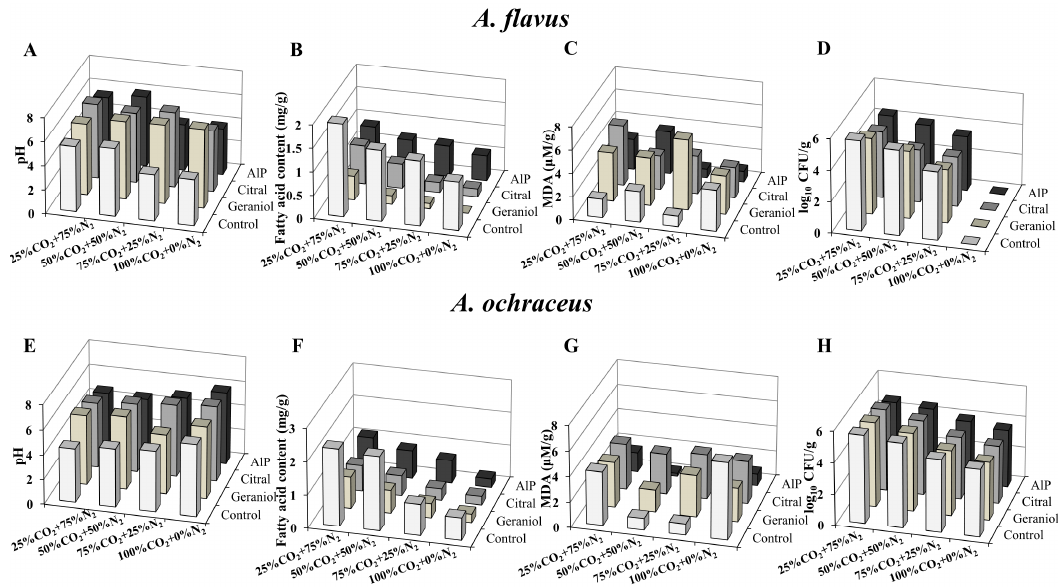
Figure 6. Effects of combined EOCs and MAP on the preservation-related parameters in rice grains. The grains were treated with geraniol (0.5 μ L/mL), citral (0.5 μ L/mL), AlP (10 mg/L), and sterile water (control) respectively for 8 days under different MAP conditions (25% CO 2 and 75% N 2 ; 50% CO 2 and 50% N 2 ; 75% CO 2 and 25% N 2 ; 100% CO 2 ) at 25–30 °C and 80–90% relative humidity (RH). ( A ) Changes in pH values with A. flavus ; ( B ) Changes in fatty acid content with A. flavus ; ( C ) Changes in MDA content with A. flavus ; ( D ) Changes in colony number of A. flavus ; ( E ) Changes in pH values with A. ochraceus ; ( F ) Changes in fatty acid content with A. ochraceus ; ( G ) Changes in MDA content with A. ochraceus ; and ( H ) Changes in colony number of A. ochraceus .